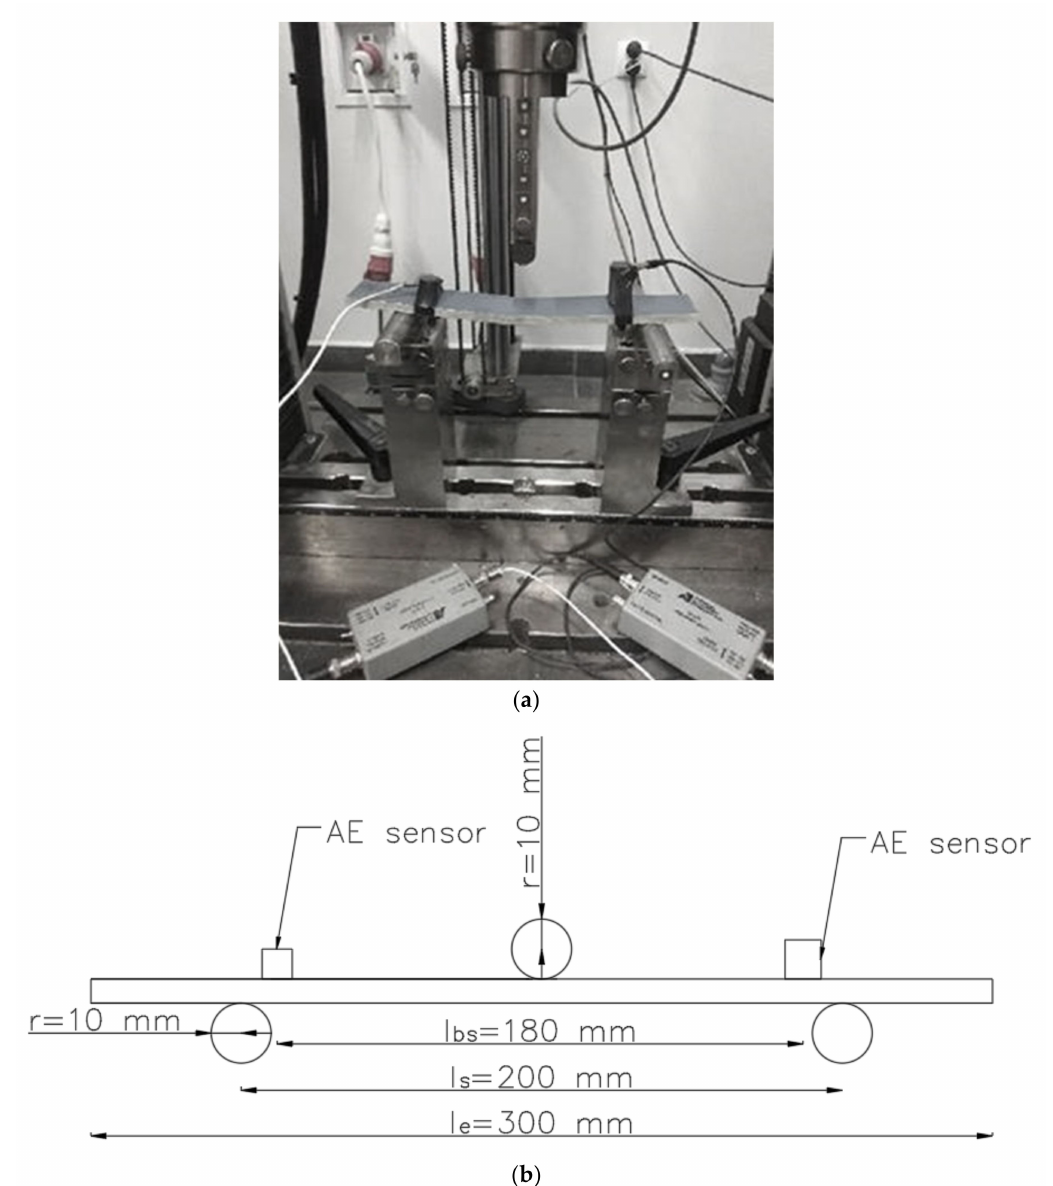
Figure 1. The fiber–cement element in three-point bending with installed AE sensors: ( a ) photograph of the specimen; ( b ) scheme of loading and AE